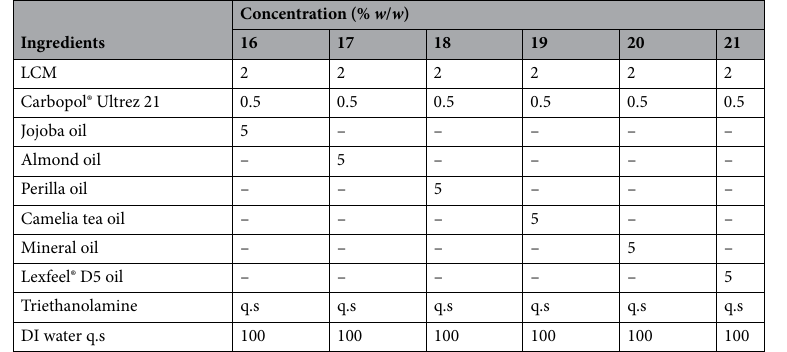
Table 7. Formulations of LLCs using different types of oils. LCM: Liquid Crystal Cream Maker (sorbitan stearate and sucrose cocoate); Carbopol® Ultrez 21: acrylates/C10–30 alkyl acrylate cross-polymer; Lexfeel® D5 oil: neopentyl glycol diheptanoate and isododecane. Formulations 16–21 used different oil types: jojoba oil, almond oil, perilla oil, camelia tea oil, mineral oil, and Lexfeel® D5 oil, respectively.